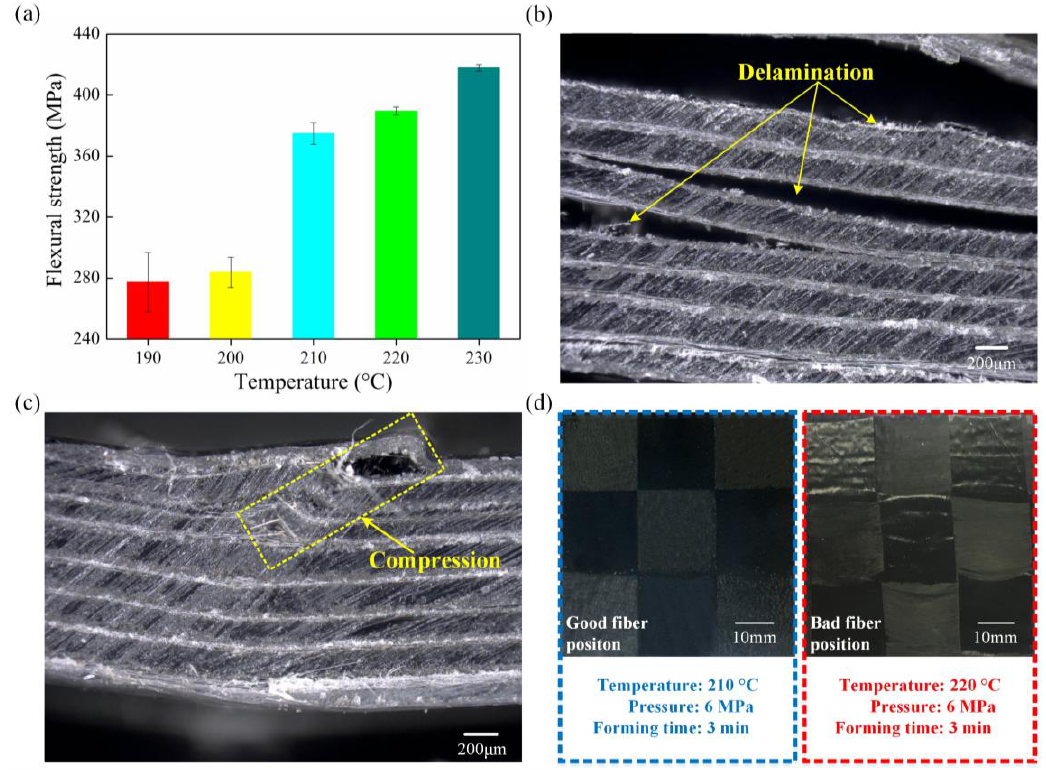
Figure 3. The flexural properties of 7-layer multi-CFPLs fabricated by different forming temperatures in the laminating-hot-press: ( a ) flexural strength bars; ( b , c ) are the digital pictures of multi-CFPLs prepared at 200 °C and 210 °C forming temperature, respectively; ( d ) shows the visual image comparison between the multi-CFPL prepared at 210 °C and 220 °C forming temperature.